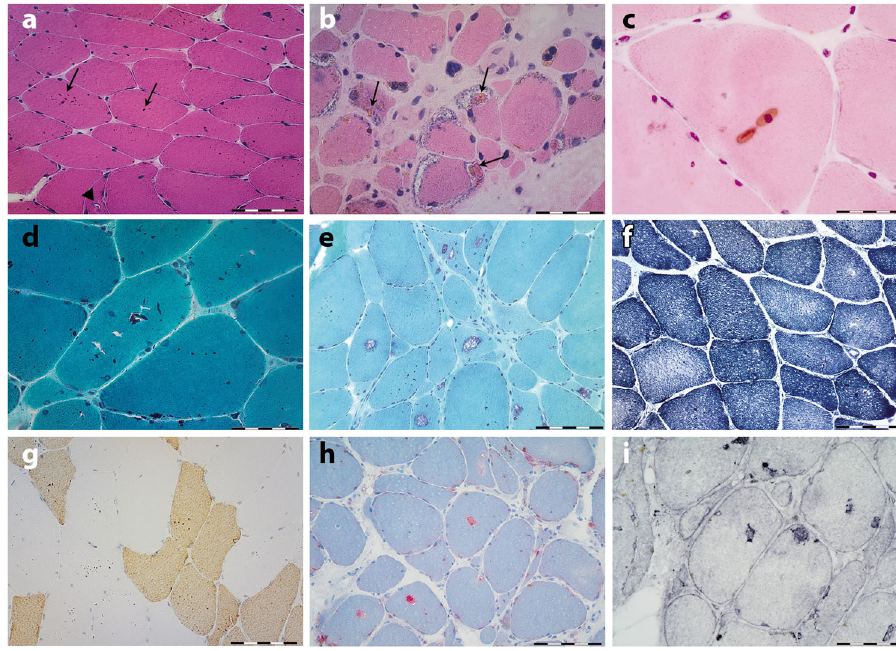
Fig. 3 Histochemical features of myoglobinopathy. a Anterior tibialis muscle biopsy from individual F3, III: 15, 10 years prior to the onset of symptoms, stained with hematoxylin and eosin, showing several rounded brown inclusions (arrows) (sarcoplasmic bodies) in the majority of myo fi bers and very small vacuoles in some myo fi bers (arrowhead in a ). b , c Biceps brachii from individual F1, II: 7, 15 years after disease onset. b Note the presence of collections of sarcoplasmic bodies within the rimmed vacuoles. d , e Sarcoplasmic bodies appear red on modi fi ed Gomori trichrome stain. e In muscle biopsies with more advanced pathological lesions, large numbers of rimmed vacuoles are observed. f No major architectural changes are seen on NADH reaction, apart from lack of oxidative activity at the site of vacuoles. g Fast myosin immunohistochemistry demonstrate the presence of sarcoplasmic bodies in both type 1 (slow) and 2 (fast) myo fi bers. h Myo fi ber regions containing vacuoles display strong phosphatase activity, and LAMP1 i immunoreactivity. Scale bar in a , e , f , g , and h = 50 µ m; scale bar in b , c , d , and i = 20 µ